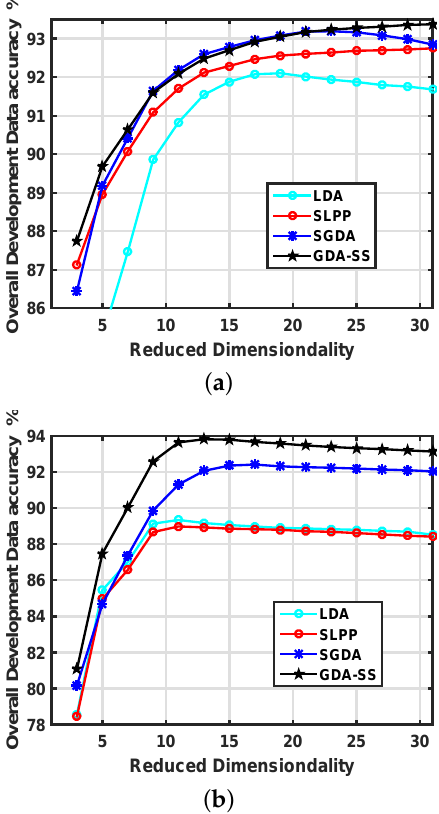
Figure 4. Classification accuracy versus reduced-dimensionality K for methods using the experimental datasets. ( a ) Salinas; ( b ) Pavia